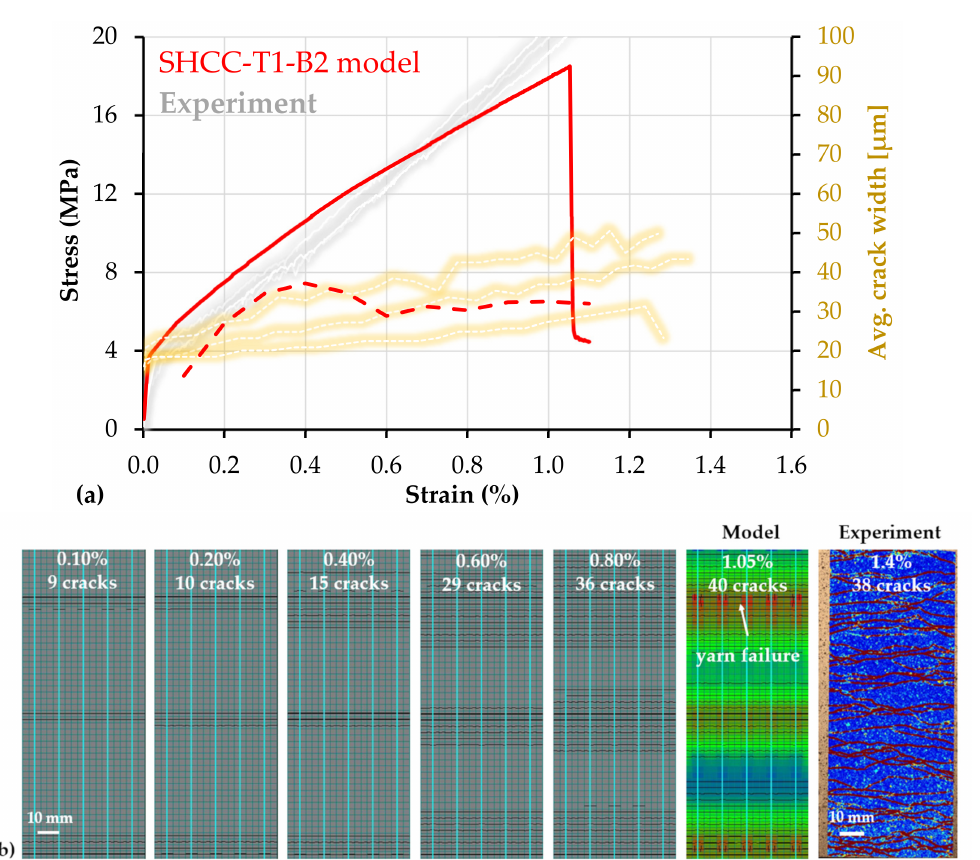
Figure 15. ( a ) Macroscopic stress–strain curve (continuous) and average crack widths (dashed) of the SHCC-T1-B2 model composite with experimental results adopted from [47]; ( b ) crack pattern and sequence in the loaded model including the principal stresses in SHCC at yarn failure and a representative experimental crack pattern based on DIC